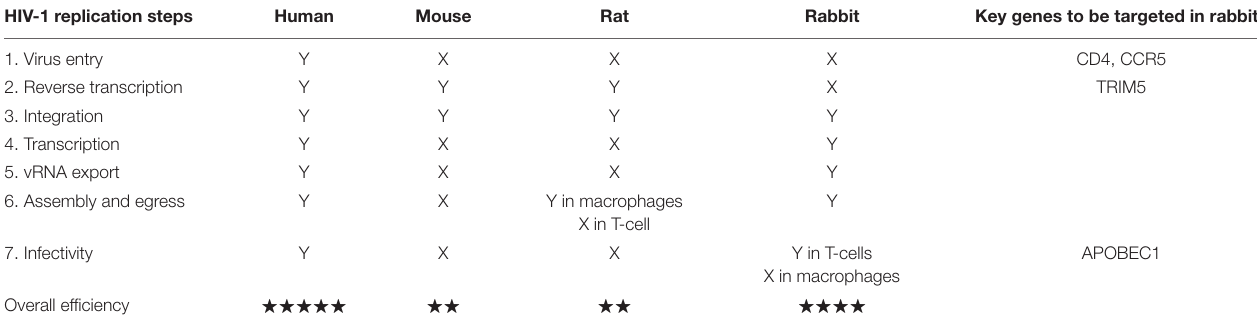
TABLE 2 | HIV-1 infection and replication barriers in mice, rats, and rabbits*. HIV-1 replication steps Human Mouse Rat Rabbit Key genes to be targeted in